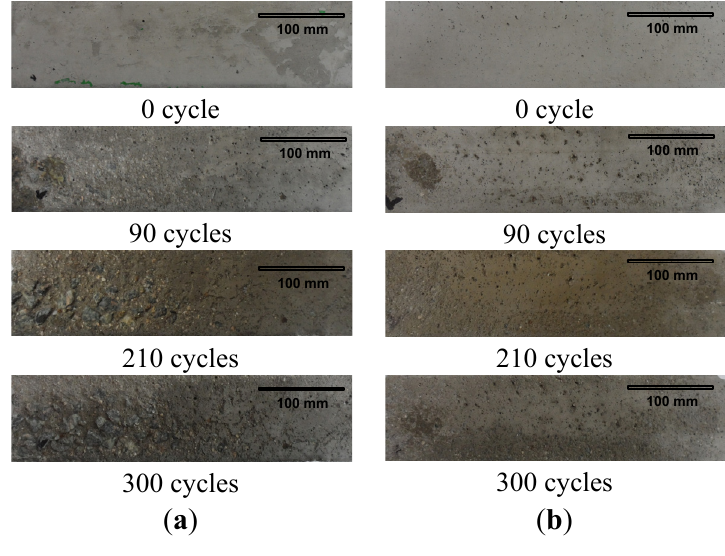
Figure 6. Surface status of ( a ) R40-CON; ( b ) R40-NS5; ( c ) R40-NS7.5; and ( d ) R40-NS10 specimens according to number of